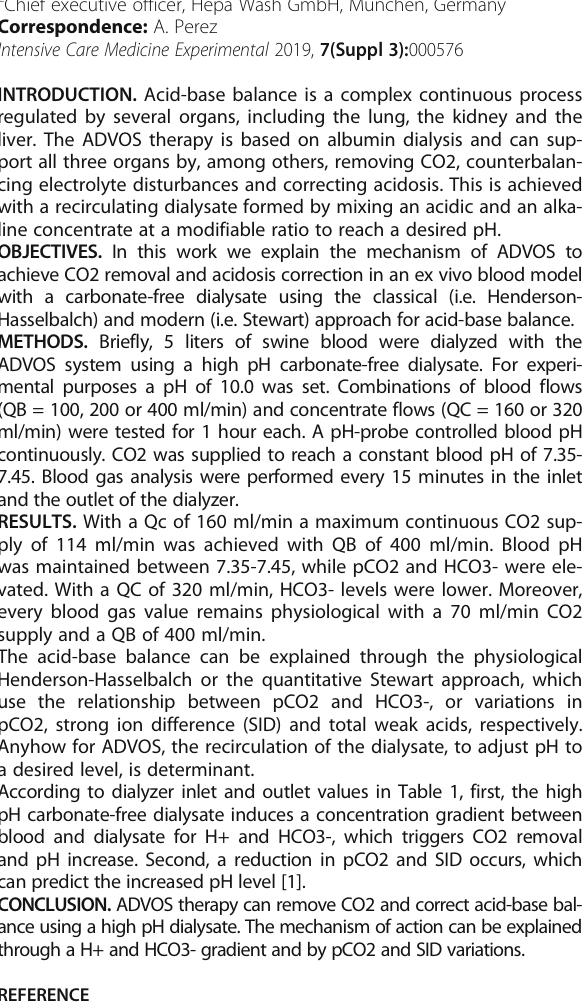
Table 1. Similar results were observed in the validation cohort (280